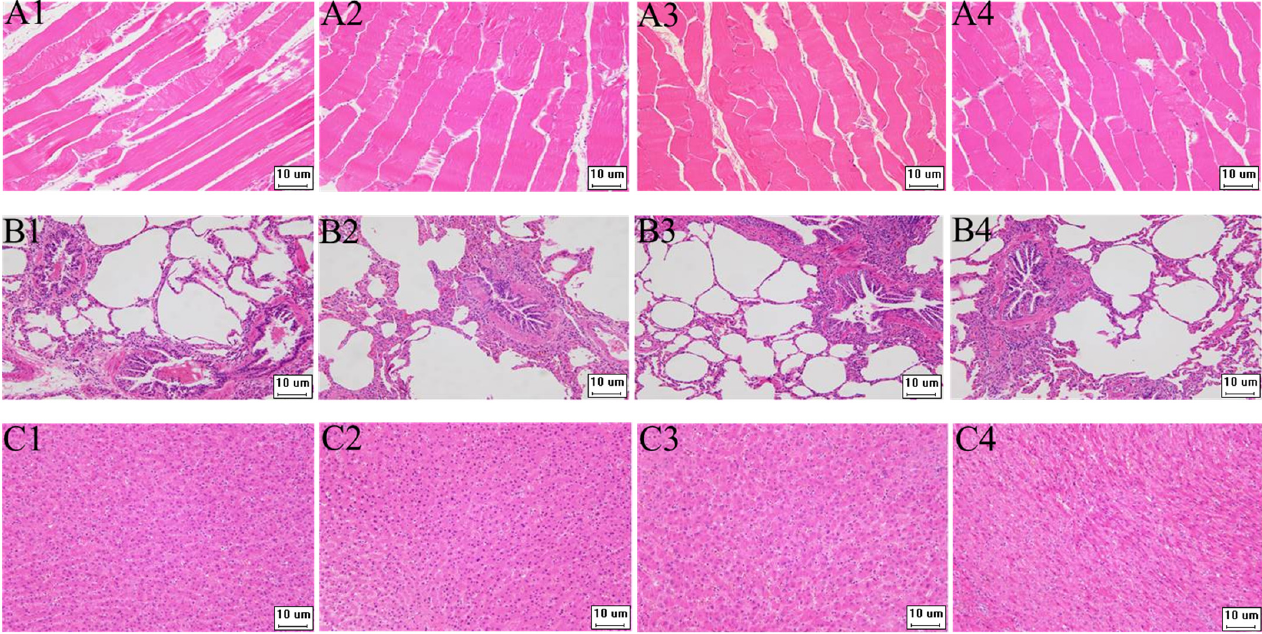
Figure 2. The pathological paraffin tissues section of pigs (200×). ( A – C ) are paraffin tissue sections of muscle, lung, and liver tissue, respectively; 1–3 are antibody ‐ positive pigs, and 4 is antibody ‐ negative pigs.